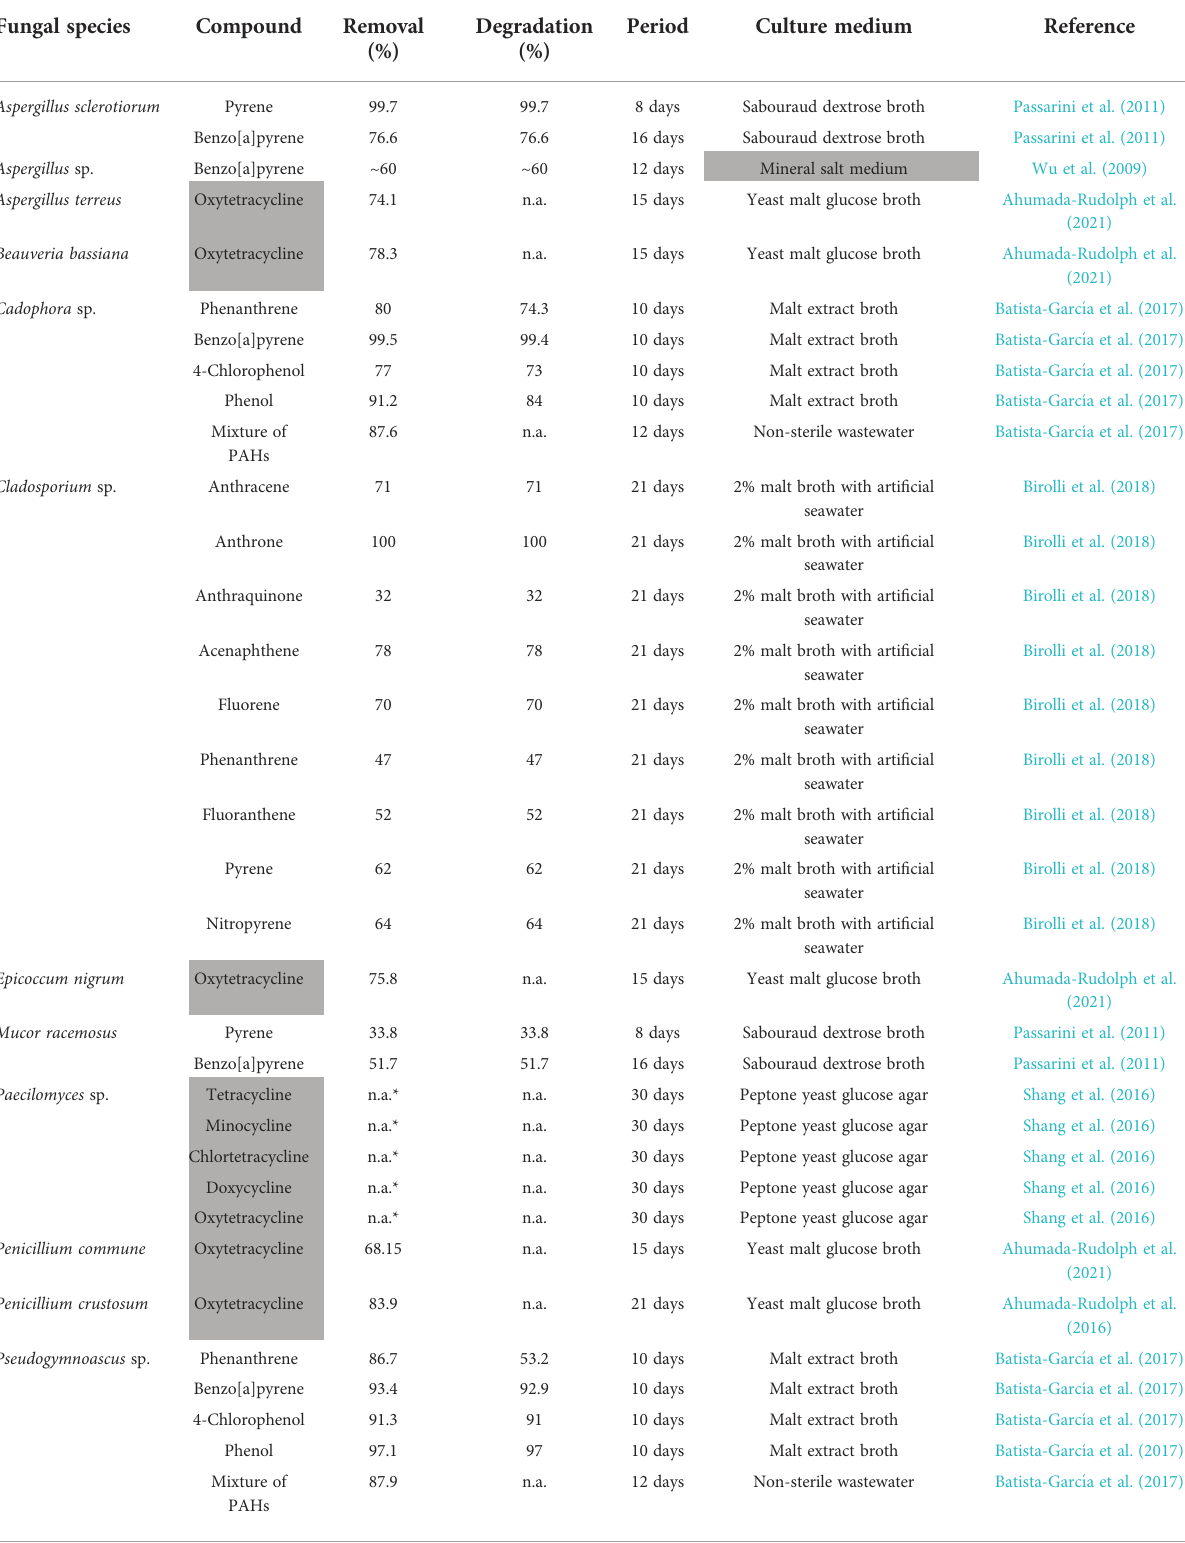
TABLE 2 Selected marine fungi and their removal rates of organic contaminants. Fungal